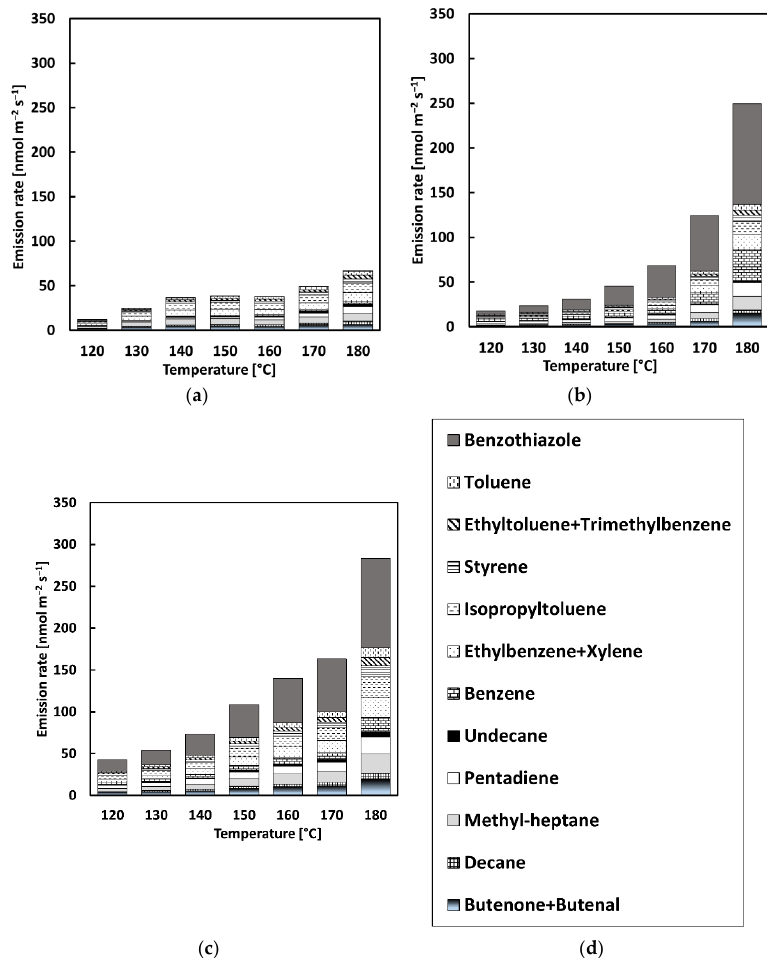
Figure 9. Distribution of VOCs with an incremental increase in temperature: ( a ) REF, ( b ) CRMB1, ( c ) CRMB2, and ( d ) legend.